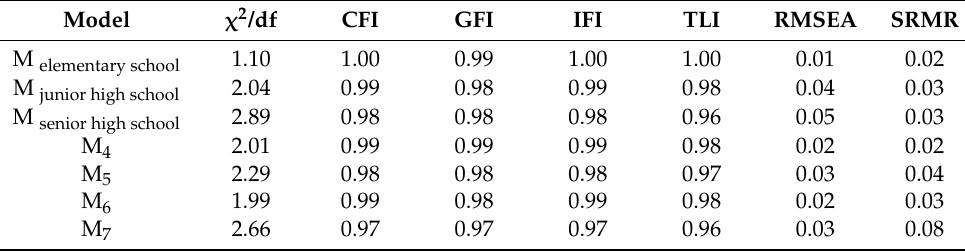
Table 6. Fitting index of multi-cohort model for multi-cohort analysis of grade difference. Model χ 2 /df